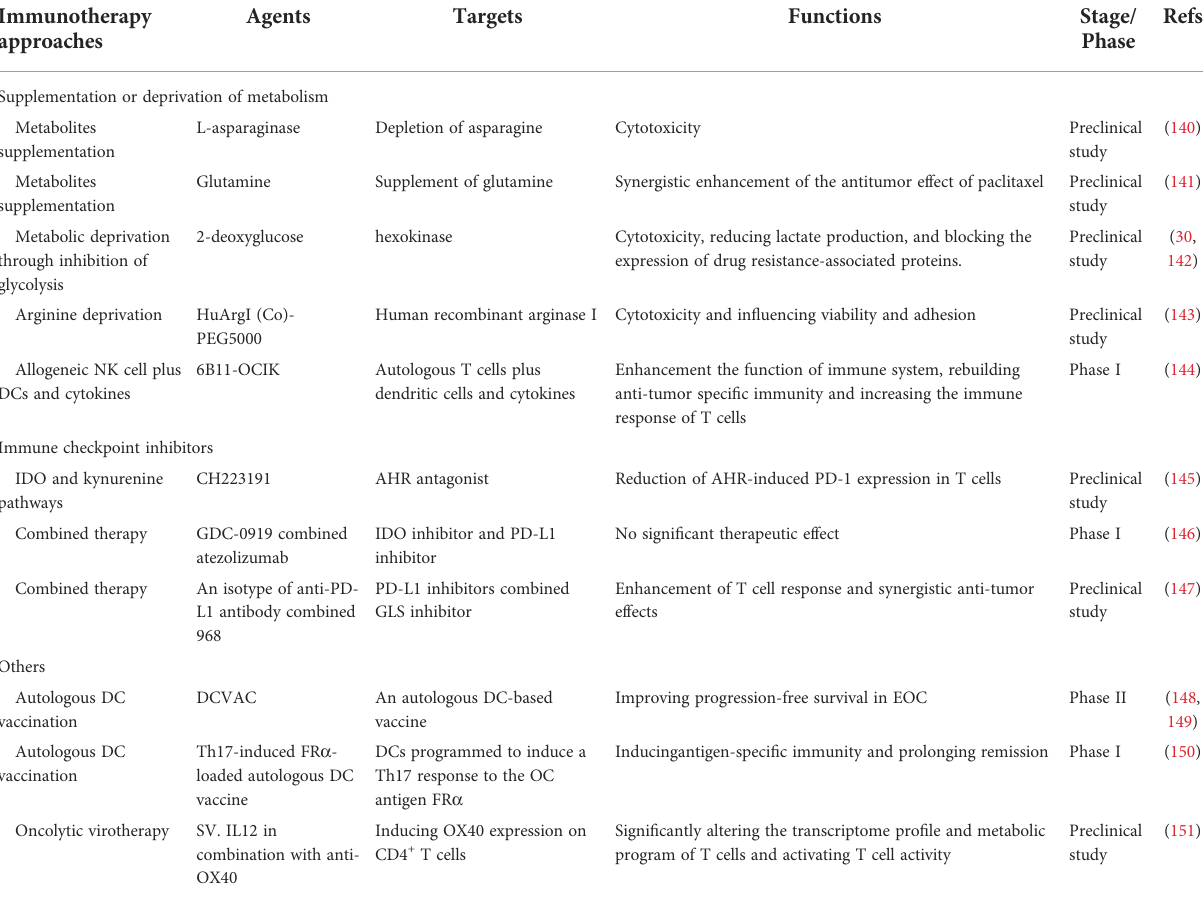
TABLE 2 Immunotherapy targeting the metabolism of immune cells in ovarian